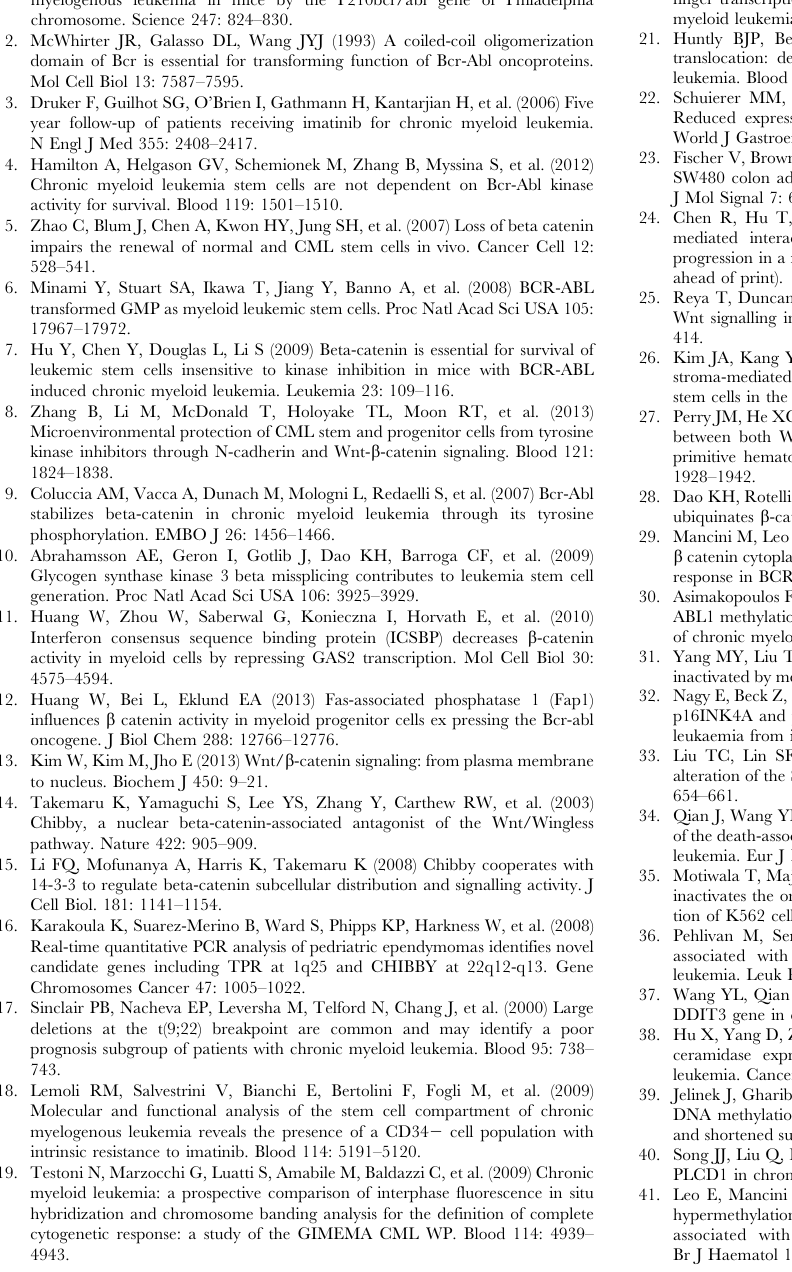
Table S4 Ratios of WB and PCR signal intensities of MCF and CD34 + cells from CML-CP patients vs HP. CBY1 protein and transcript, beta catenin nuclear protein and cyclin D1 transcript levels in MCF and CD34 + cells of HP and CML-CP patients were expressed as